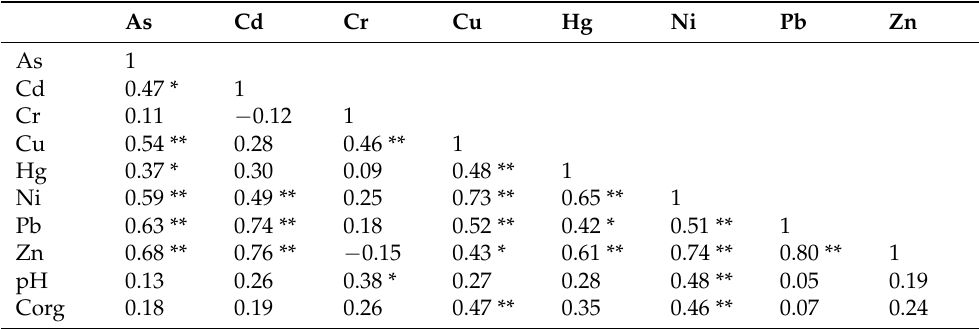
Table 4. Pearson’s correlation analysis of heavy metal elements and basic physical and chemical properties of soil in the non-karst area.